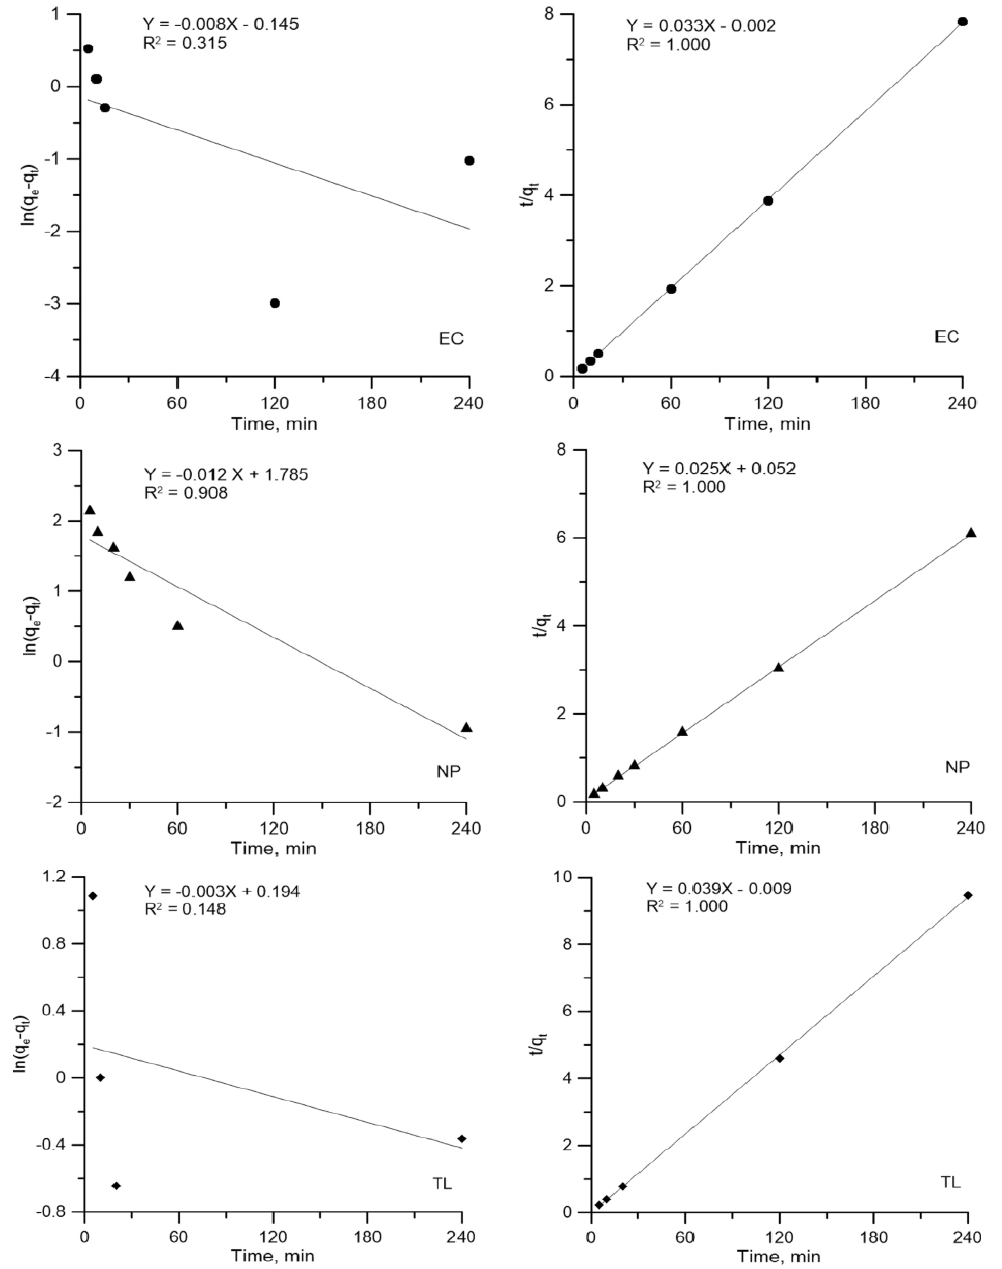
Fig. 7. Pseudo first and second order kinetic curves